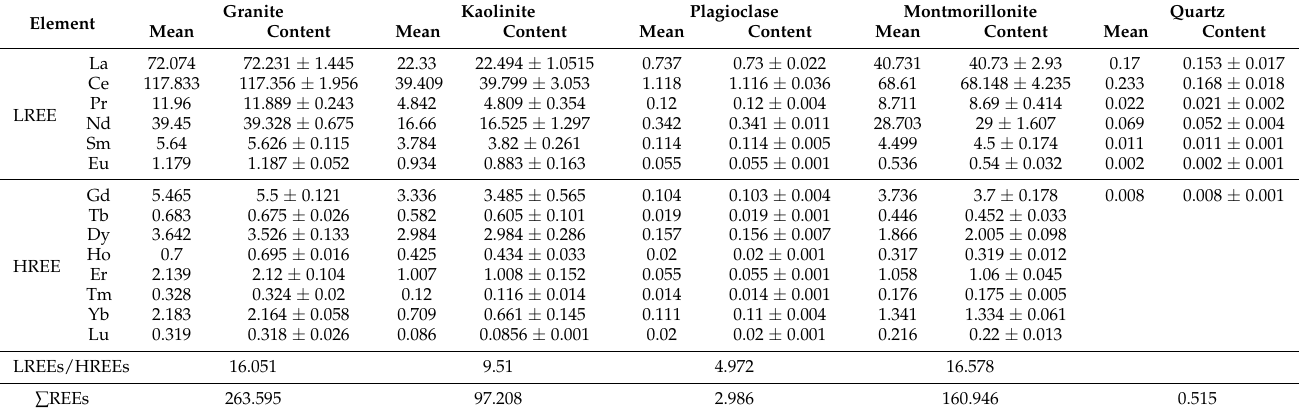
Table 2. Contents of REEs in the raw mineral samples ( µ